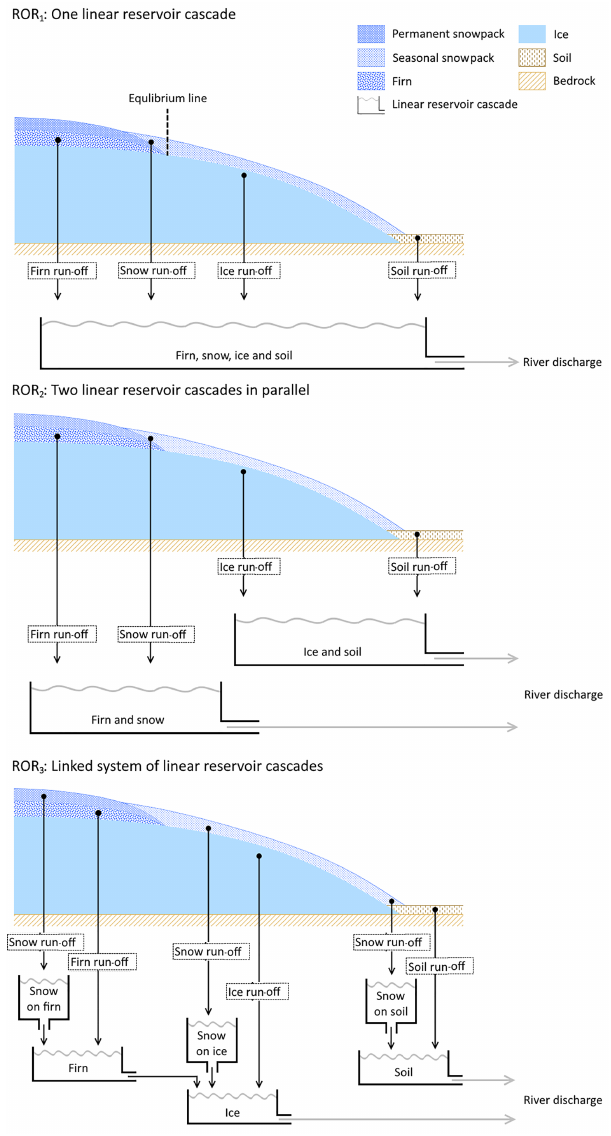
Figure 2. Three run-off-routing model structures which relate the linear reservoir cascade configurations to idealised cross sections of a temperate